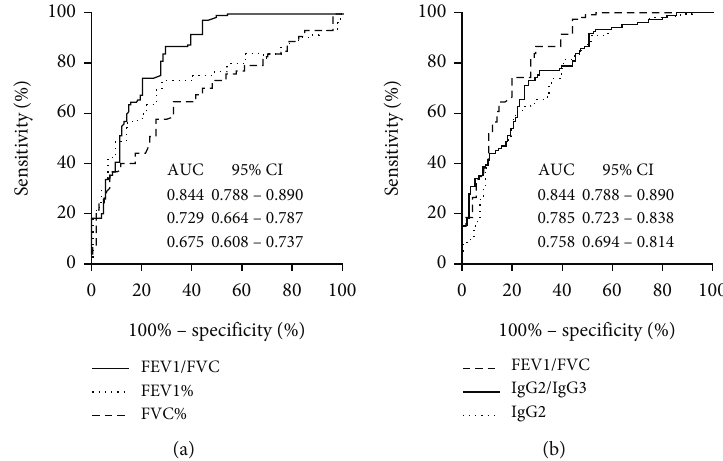
Figure 4: ROC analysis of the spirometry parameters and the IgG2/IgG3 ratio for distinguishing CWPs and DEWs. (a) ROC analysis of the spirometry parameters for CWP and DEW discrimination. (b) ROC analysis of the IgG2/IgG3 ratio, FEV1/FVC, and IgG2 for CWP and DEW discrimination. FVC: forced vital capacity; FEV1: forced expiratory volume in the fi rst second; AUC: area under the